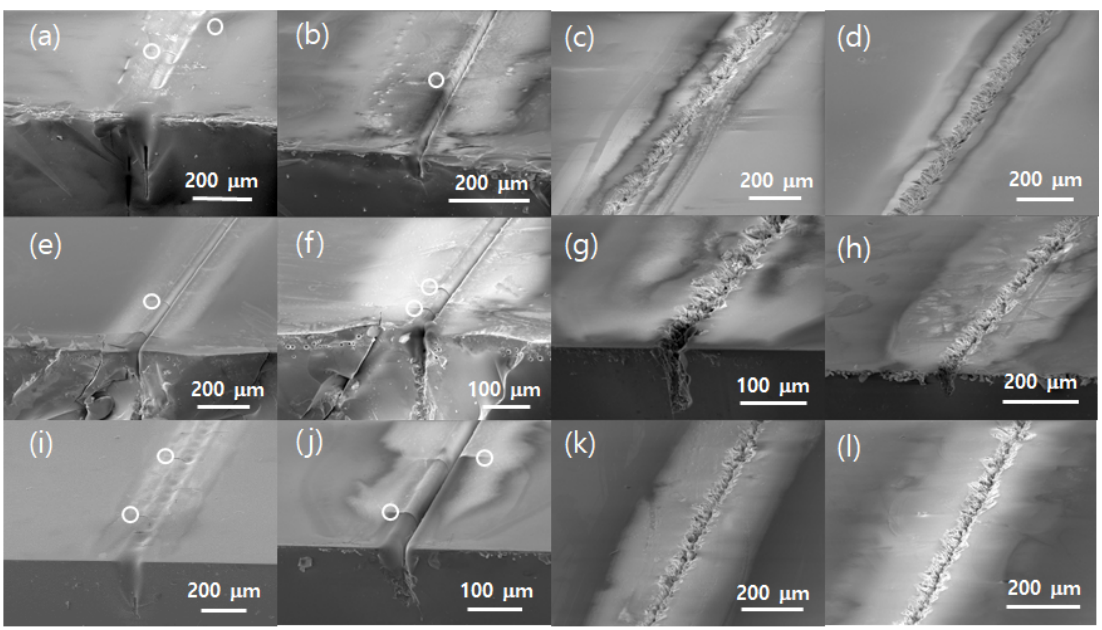
Figure 6. SEM images of the glass surface damaged by a single laser scan. Laser power: ( a – d ) 2.2 W, ( e – h ) 2.8 W, and ( i – l ) 3.32 W. Scan speed: ( a , e , i ) 5 mm/s; ( b , f , j ) 15 mm/s; ( c , g , k ) 25 mm/s; and ( d , h , l ) 35 mm/s. The circle in the figure denotes a crack.